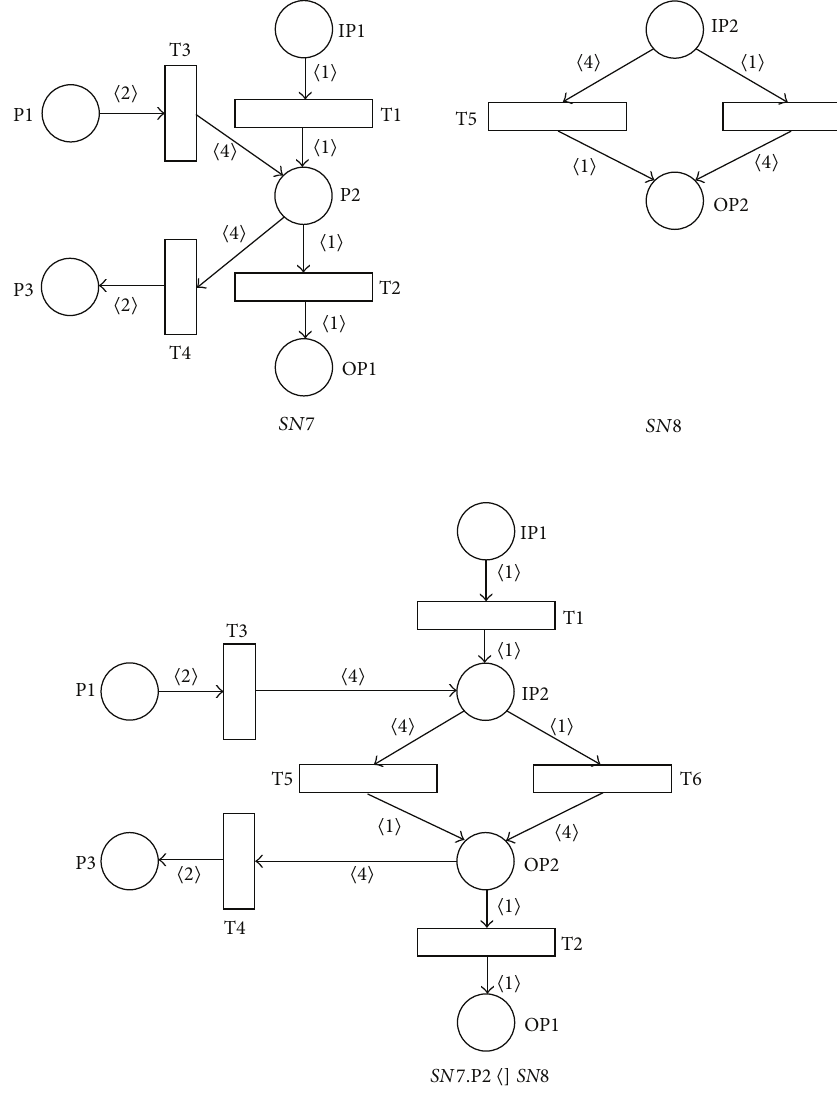
Figure 9: Result of place-substitution operation 𝑆𝑁7. P2 ⟨] 𝑆𝑁8